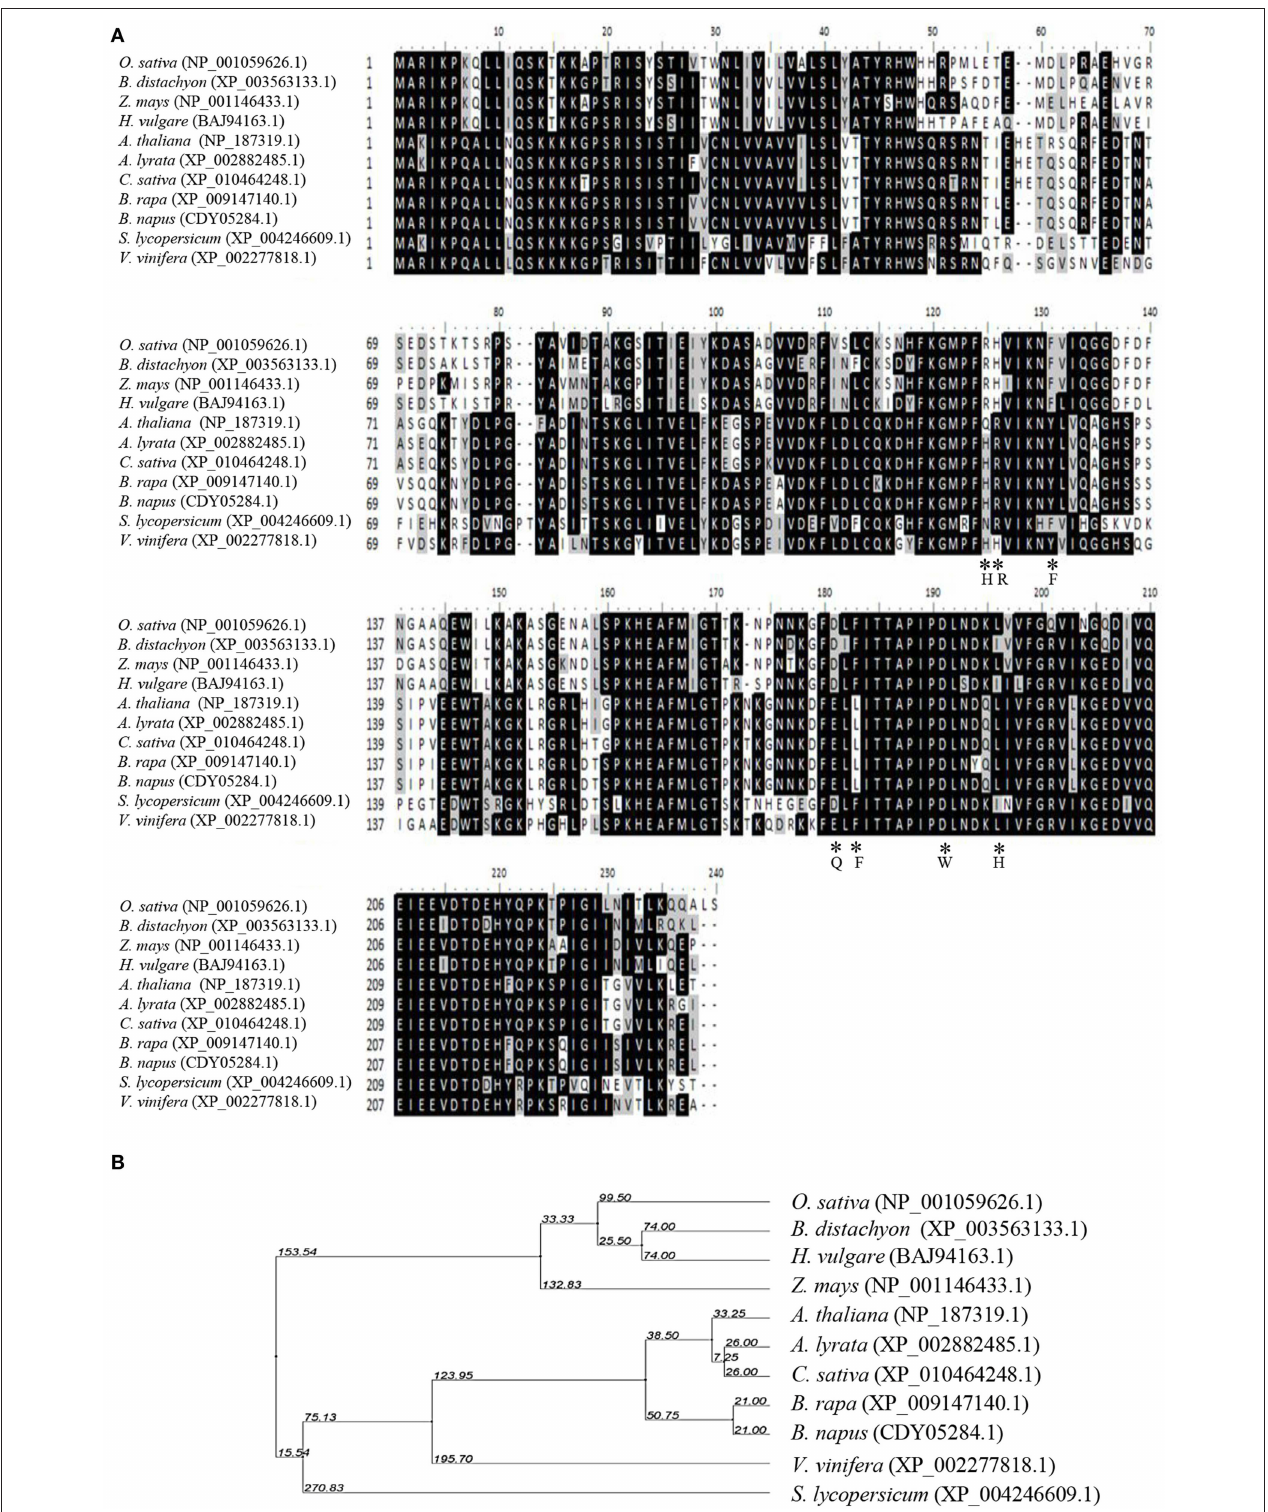
FIGURE 1 | Multiple sequence alignment and phylogenetic relationship between OsCYP21-4 and CYP21-4 homologs from various plants. (A) Sequence comparison of OsCYP21-4 protein with selected CYP21-4 homologs from various plant species. The amino acids necessary for PPIase activity/CsA binding and are marked by asterisks. The degree of background shading indicates amino acid identity and similarity ( black: identity > 50%, gray: similarity > 50%). (B) Phylogenetic distance between OsCYP21-4 and other homologs.